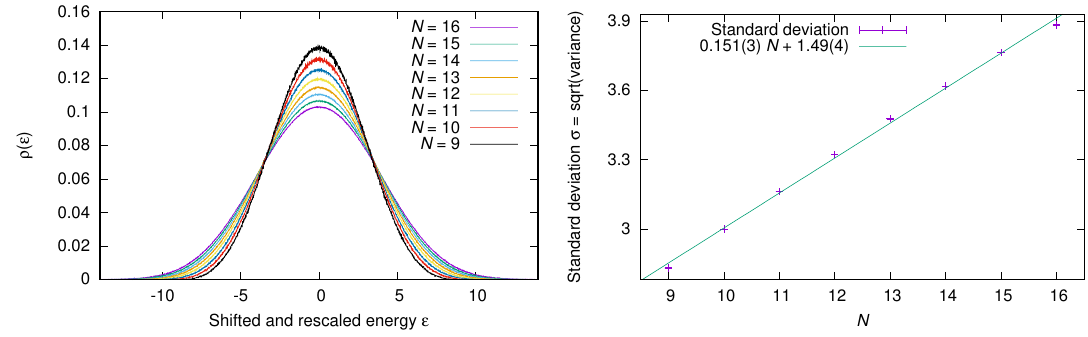
Figure 5 . The density of shifted and renormalized eigenvalues for the 2-local RCQ model for N = 9 ; 10 ; : : : ; 16, and the averaged variance of eigenvalues with a straight line (cid:12)t. (2 16 (cid:0) N (cid:2) 100) samples have been used for each N